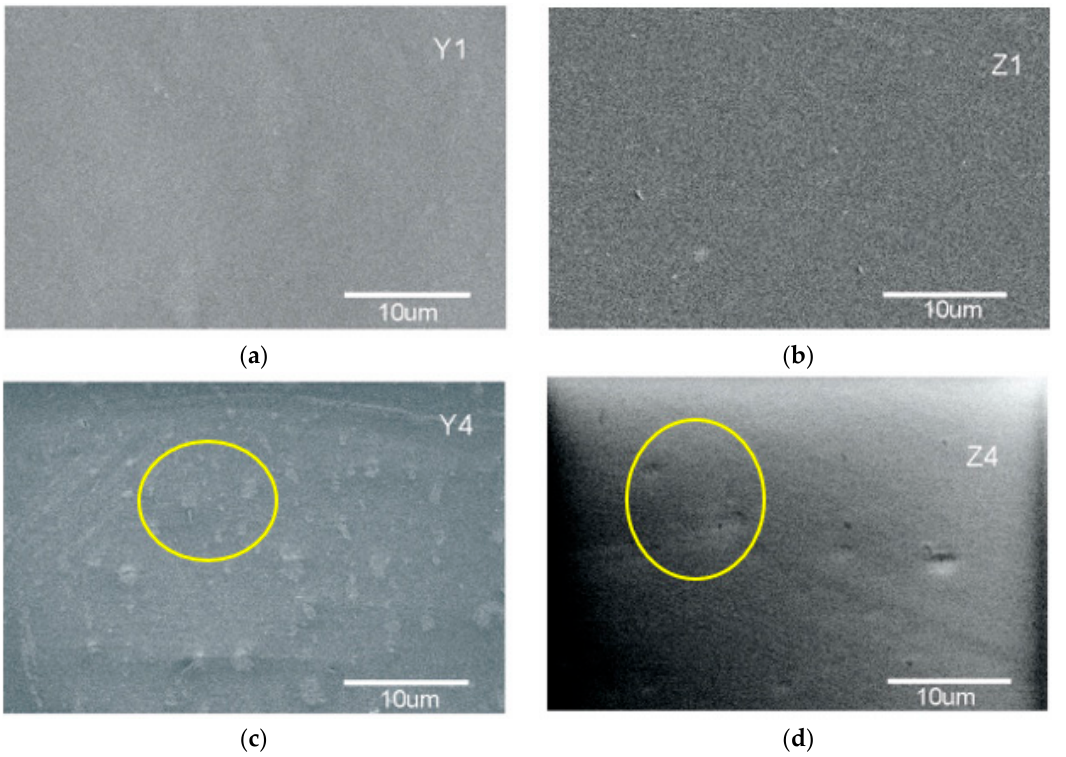
Figure 7. SEM images for PVA-ZnO membranes: ( a ) Y1; ( b ) Z1; ( c ) Y4; ( d ) Z4.